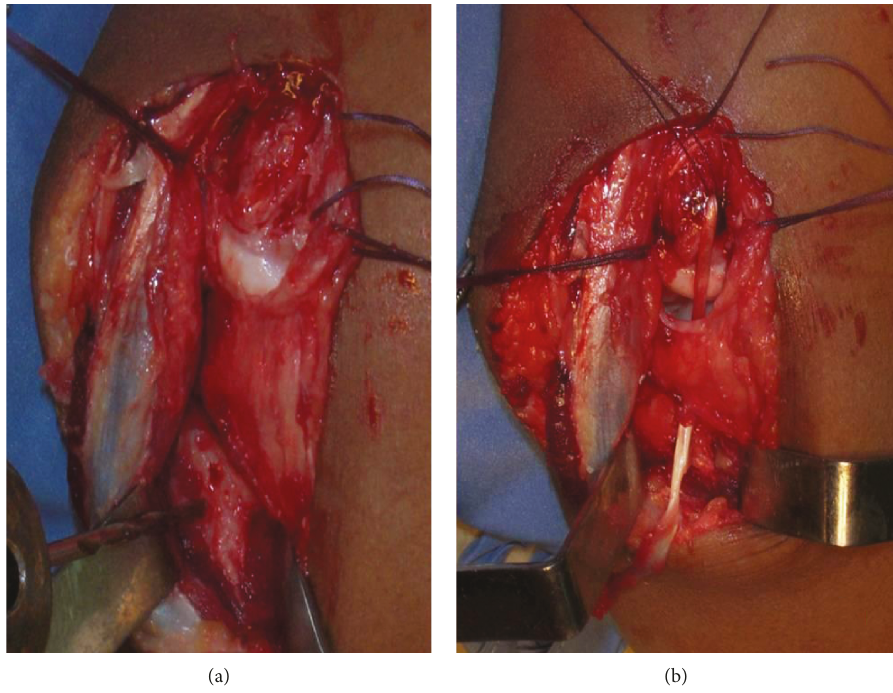
Figure 3: Case 2. (a, b) Collateral ligament reconstruction.